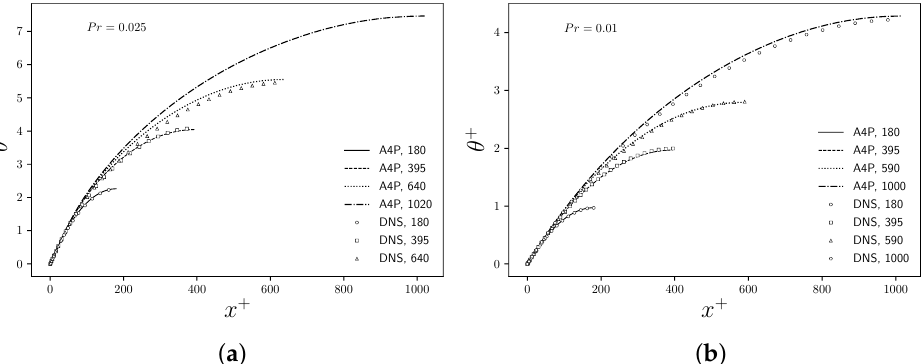
Figure 4. Non-dimensional mean temperature profile θ + in the cases of Pr = 0.025 ( a ) and Pr = 0.01 ( b ) for different Re τ = 180, 395, 590, 640, 1000, 1020. DNS data from [17] for Pr = 0.025 and [19,20] for Pr = 0.01.